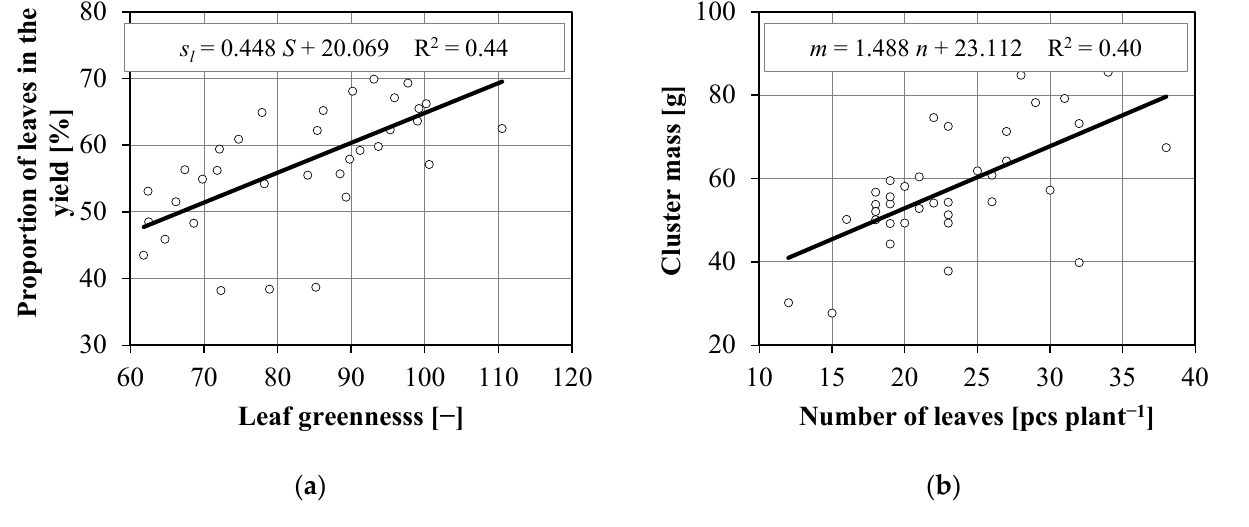
Figure 5. Correlations between the morphological parameters of shallot plants: ( a ) leaf greenness and proportion of leaves in the yield, ( b ) number of leaves and cluster mass.